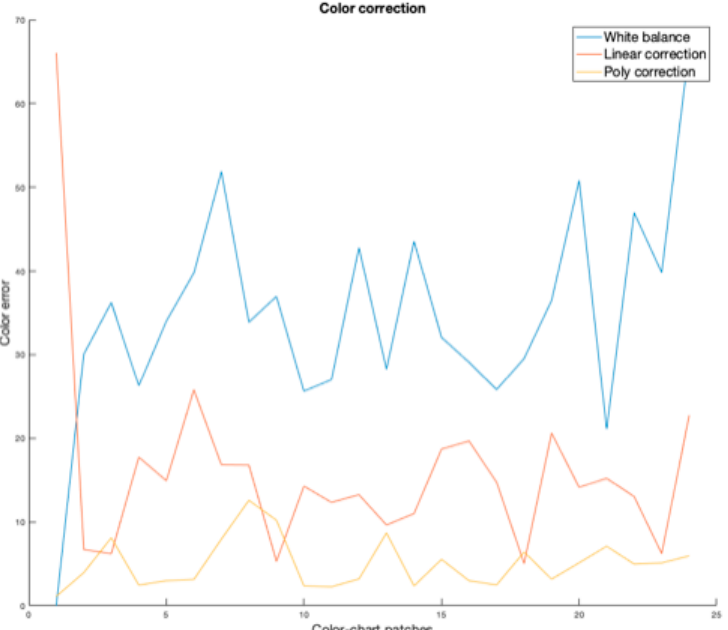
Figure 4. Average difference (Euclidean distance) between the expected colors and the measured values over the dataset of images corrected using White Balance (blue), Linear Correction (orange), Polynomial Correction (yellow). In abscissa there are the different color patches of the color chart.